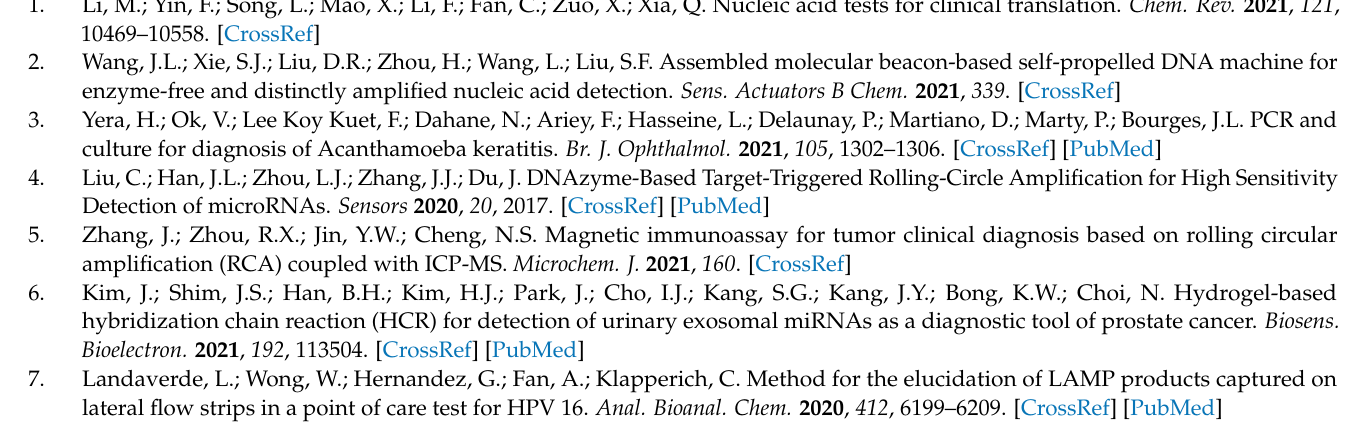
Figure S7: zeta potential of magnetic beads and magnetic beads labelled with trapping